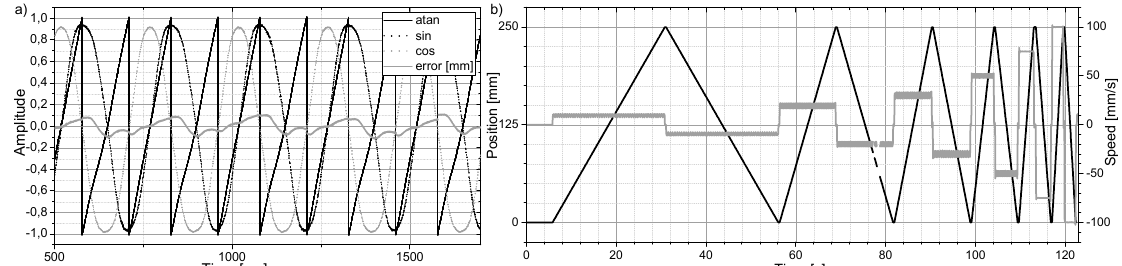
Figure 2. ( a ) Excerpt of sine and cosine signals of spindle teeth measurement, derived arctangent signal and position error during constant velocity phase (20 mm/s); ( b ) speed measurement and absolute position integrated during positioning with six velocity levels (10, 20, 30, 50, 75, 100 mm/s).